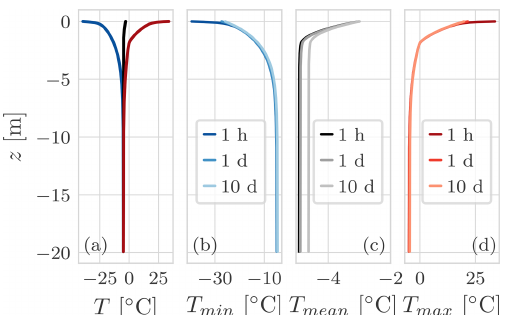
Figure 12. (a) The minimum, mean, and maximum temperature profile for the hourly simulation. Panels (b) , (c) , and (d) show the comparison of the minimum, mean, and maximum temperature pro- file respectively for the three simulations: with an hourly air tem- perature boundary condition and (cid:49)t = 1h, with a daily air temper- ature boundary condition and (cid:49)t = 1d, and with a 10d air temper- ature boundary condition and (cid:49)t = 10d. All three simulations last 100 years. The maximum difference of T mean between the hourly and daily simulation is 0 . 04 ◦ C, while between the hourly and 10d simulation the difference is 0 . 3 ◦